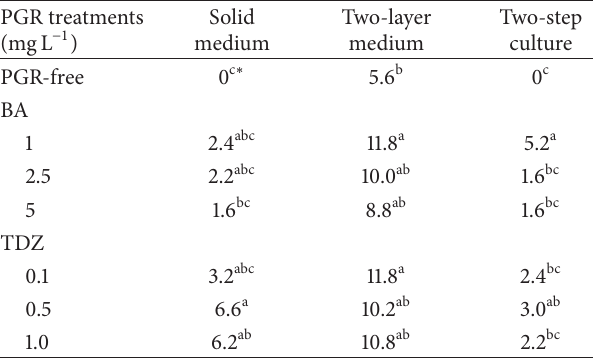
Table 2: Number of embryos formed on the distal site of shoot of 4-month-old seedlings, depending on culture systems and concen- tration of cytokinins.